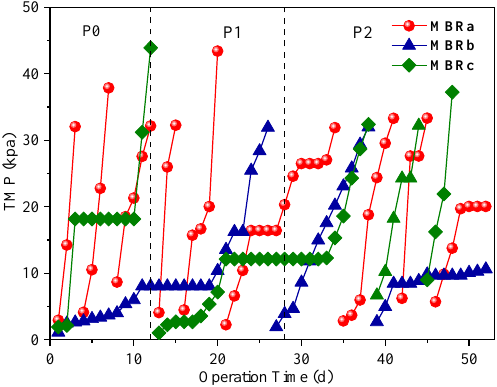
Figure 4. Variations in transmembrane pressure (TMP) in each MBRs.